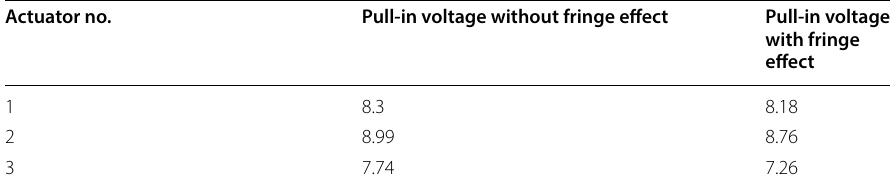
Table 3 Pull-in voltage simulated by ANSYS for the actuators in Table 1 Actuator no.